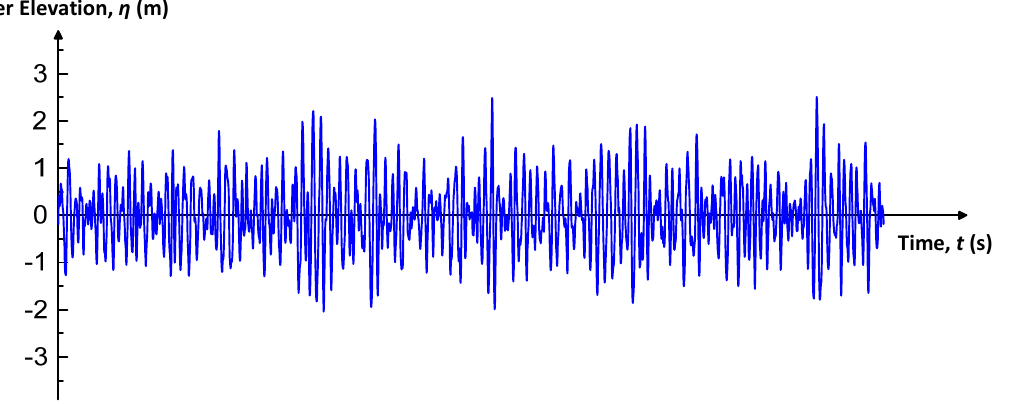
Figure 16. Waveform of JONSWAP spectrum under normal wave condition. Table 4. JONSWAP parameters for normal and storm wave conditions around the Taitung area. γ